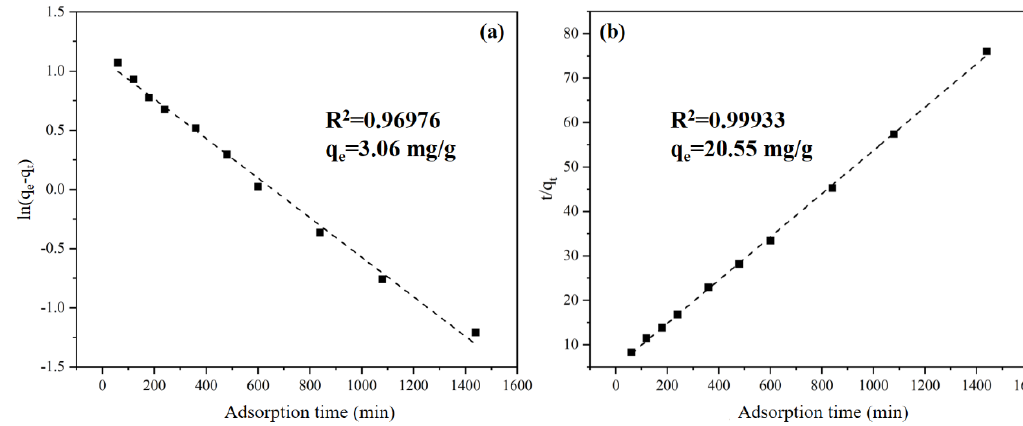
Figure 5. Fitting line of pseudo-first order ( a ) and pseudo-second order ( b ).